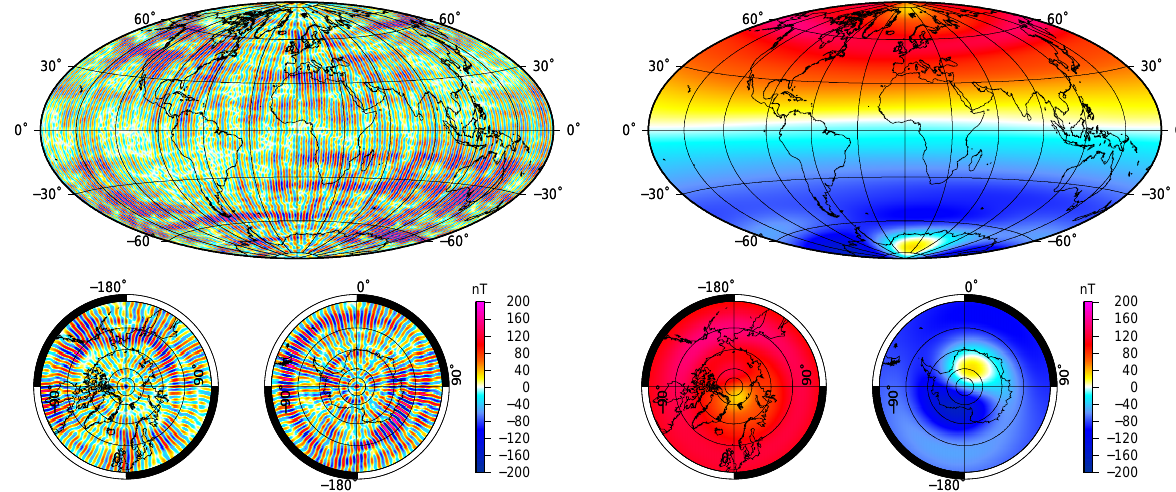
Fig. 7. Left: Map of the vertical down components of (left) the noise model and (right) the perturbation model. Both maps have been calculated at r = 6371 . 2km radius. By definition, the perturbation model is very smooth in longitude, but that does not preclude a large complexity for the noise